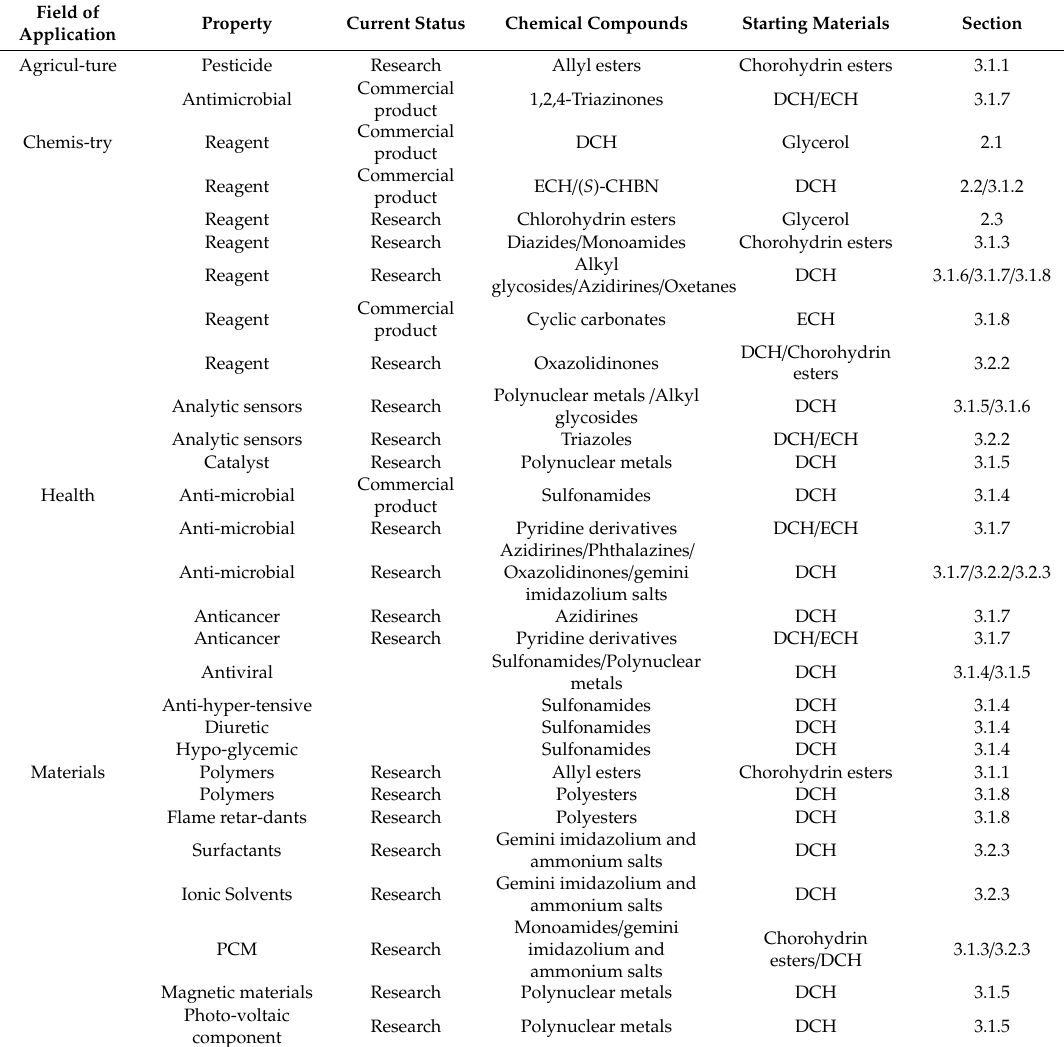
Table 4. Summary of the properties of the di ff erent products obtained from glycerol based on